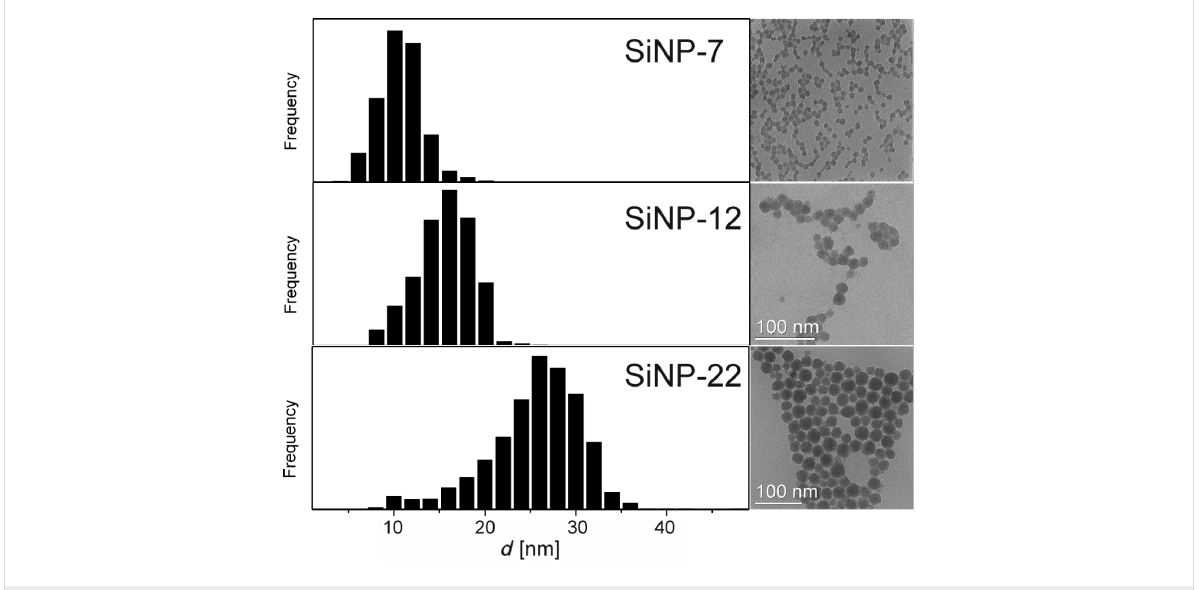
Figure 1: Microscopic d etermination of NP size from TEM image analysis.